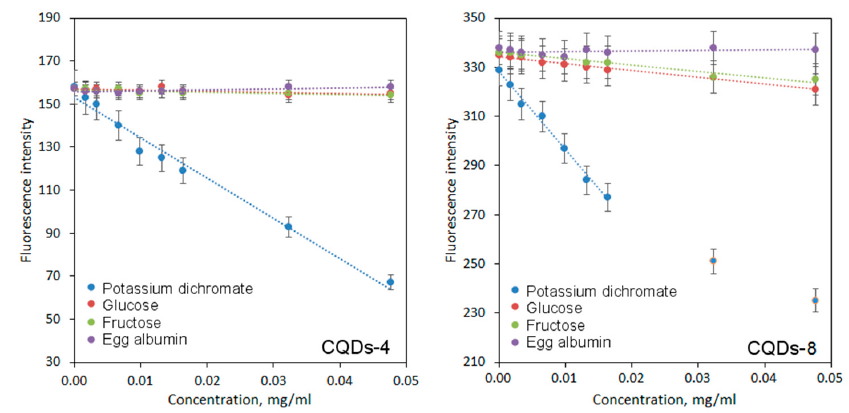
Figure 9. Sensing abilities of coumarin-modified CQDs .